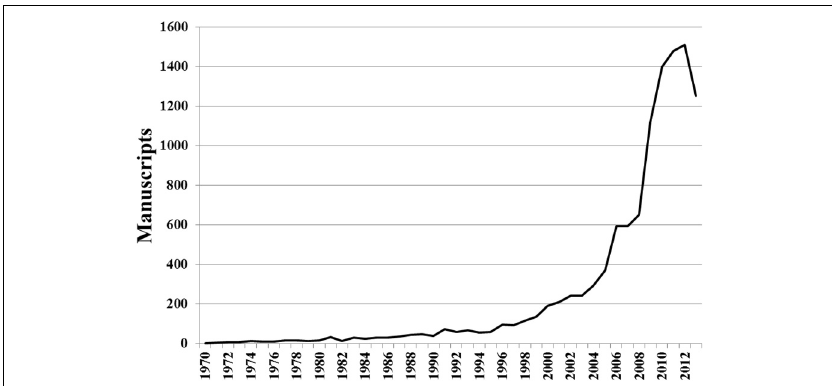
FIGURE 1 | Number of manuscripts published under the term: “marine ecosystem,” appearing in the abstract, title or keywords, since 1970, within the Science Citation Index journal (consulted in SCOPUS, on 17th November